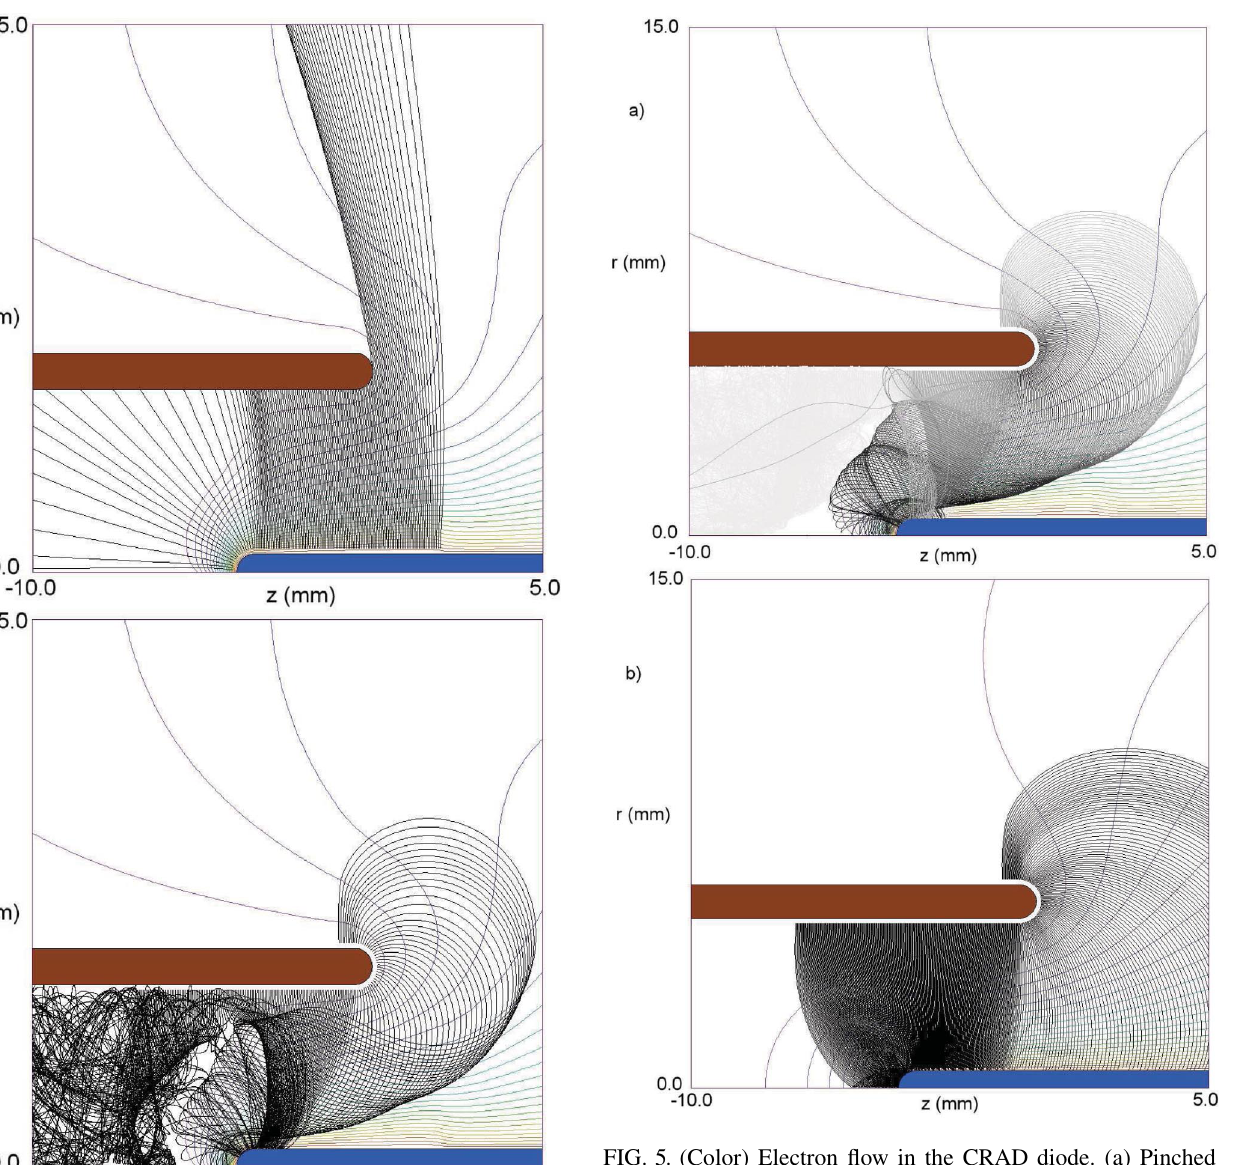
FIG. 5. (Color) Electron flow in the CRAD diode. (a) Pinched beam with ions present—electron orbits shaded according to model-particle current. (b) Electron flow with no ions—all orbits plotted.FIG. 4. (Color) Calculated trajectories and equipotential lines (cid:5) 5 : 0 mm and L (cid:5) 4 : 0 mm . (a) c ac